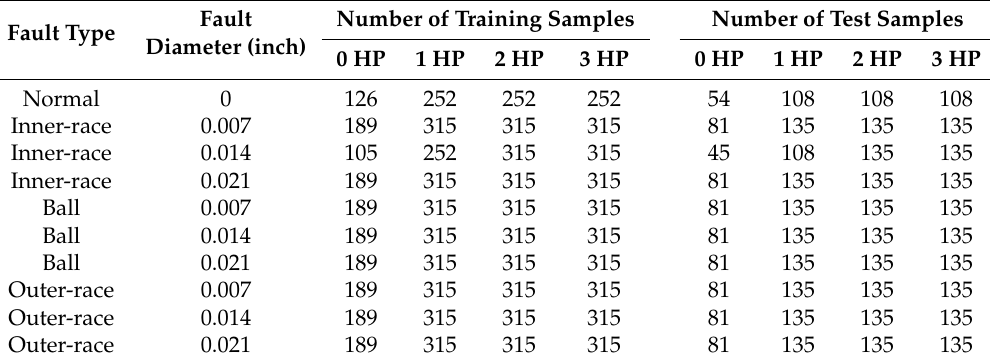
Table 4. Division of dataset composed of 1D raw vibration signals.